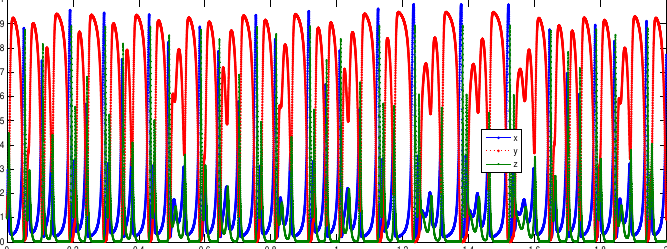
Figure 7. Time responses of the system (4) whith the parameters given in (18) and h = 0.1.